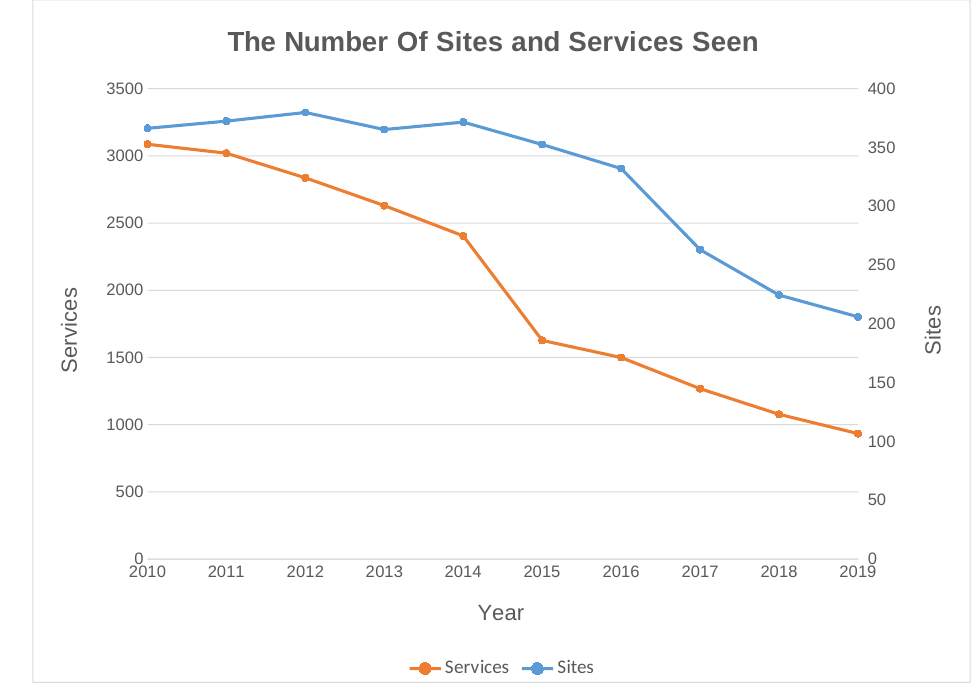
Figure 1. The number of sites and services seen in the grid information system (GLUE 1.3).